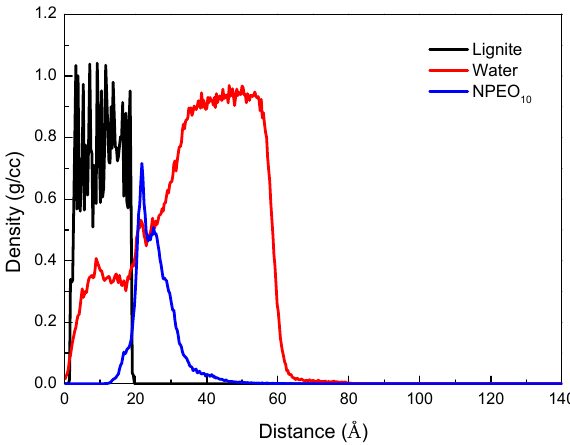
Figure 4. Density distributions of coal, NPEO 10 , and water molecules along the Z axis direction.